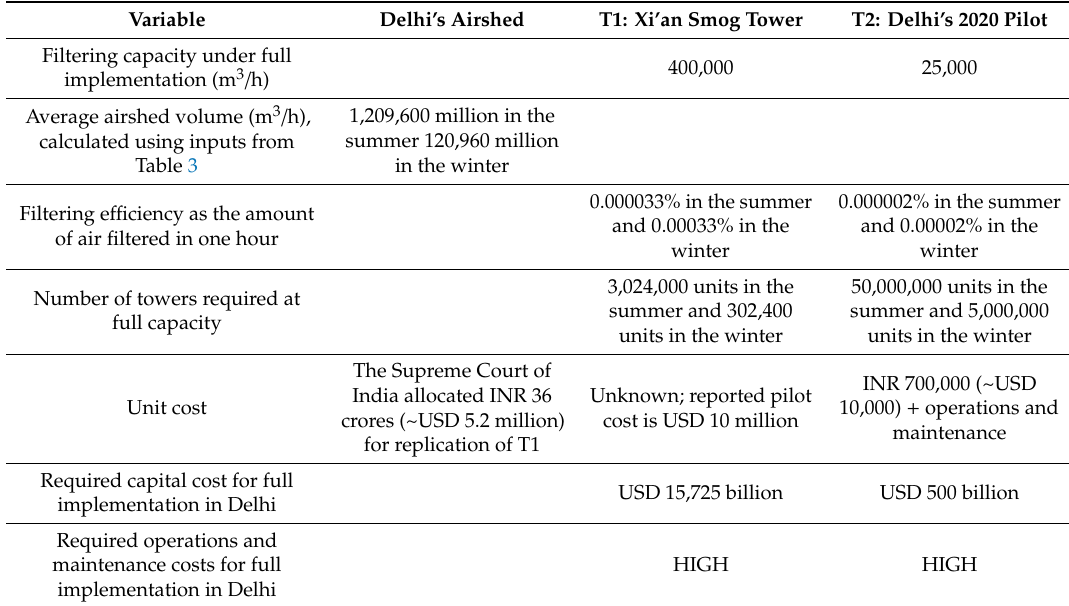
Table 2. Outdoor air pollution filtering e ffi ciency of the smog towers in Delhi’s airshed.